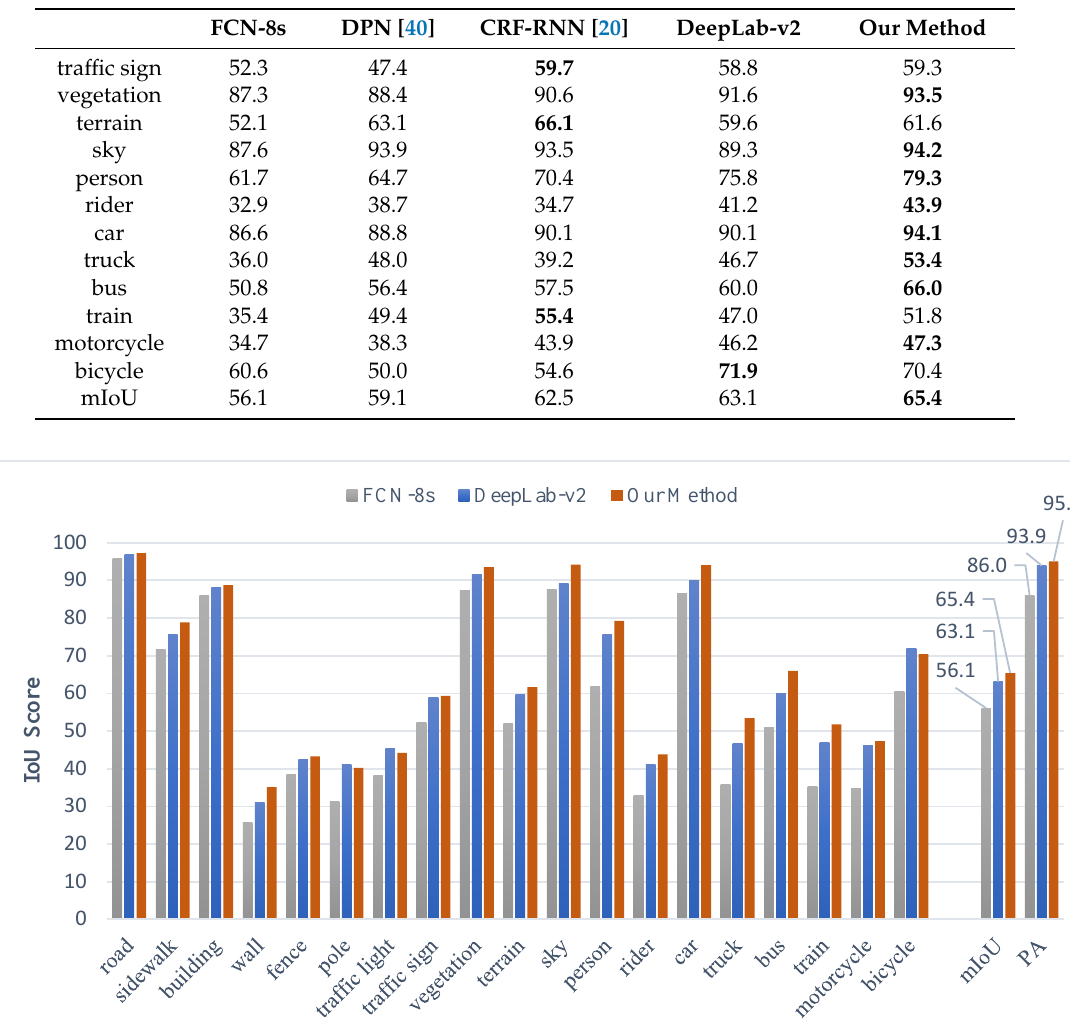
Figure 15. The improvement by our method compared with FCN-8s and DeepLab-v2.